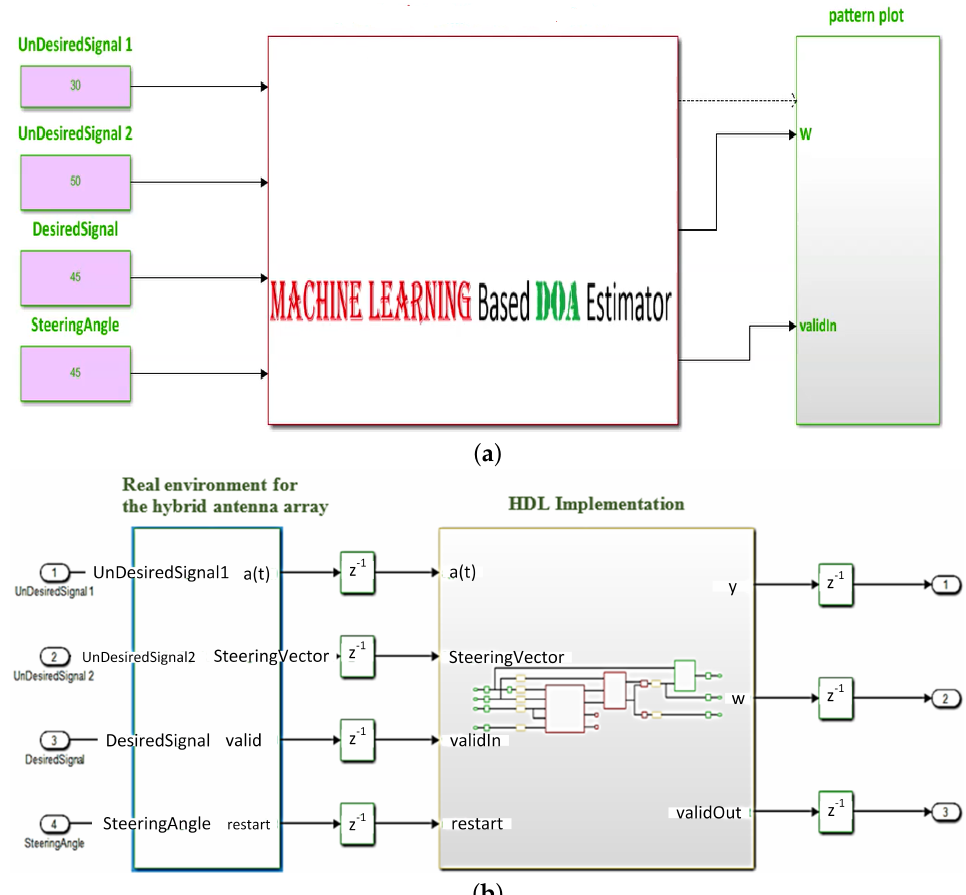
Figure 3. ( a ) A demonstration of the proposed QS-SVM-based digital beamformer. Here, position vectors are assumed to be in a plane of θ variable and φ constant. An angle of 45 ◦ is the direction of a desired signal, and the steering angle should be identical to it. However, angles of 30 ◦ , and 50 ◦ represent the directions of undesired signals, and ( b ) a demonstration of the proposed QS-SVM-based digital beamformer in the real and hardware